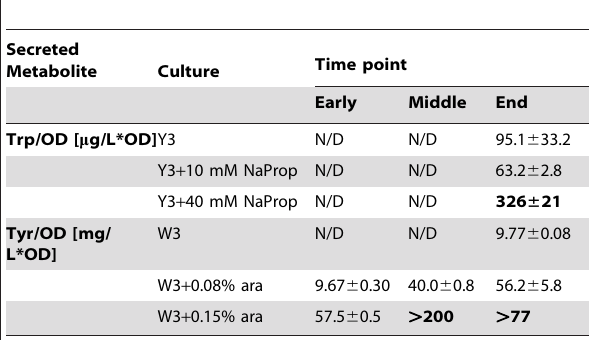
Table 1. Culture-averaged secretion of Tyr and Trp in mono- culture growth